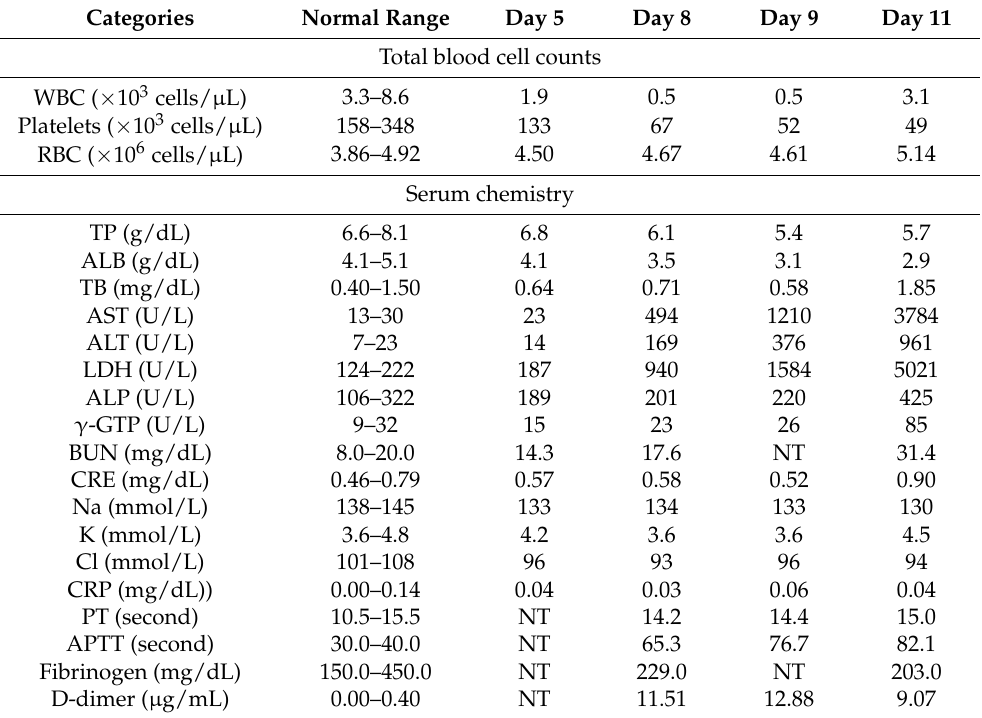
Table 1. Sequential laboratory data of the patient with